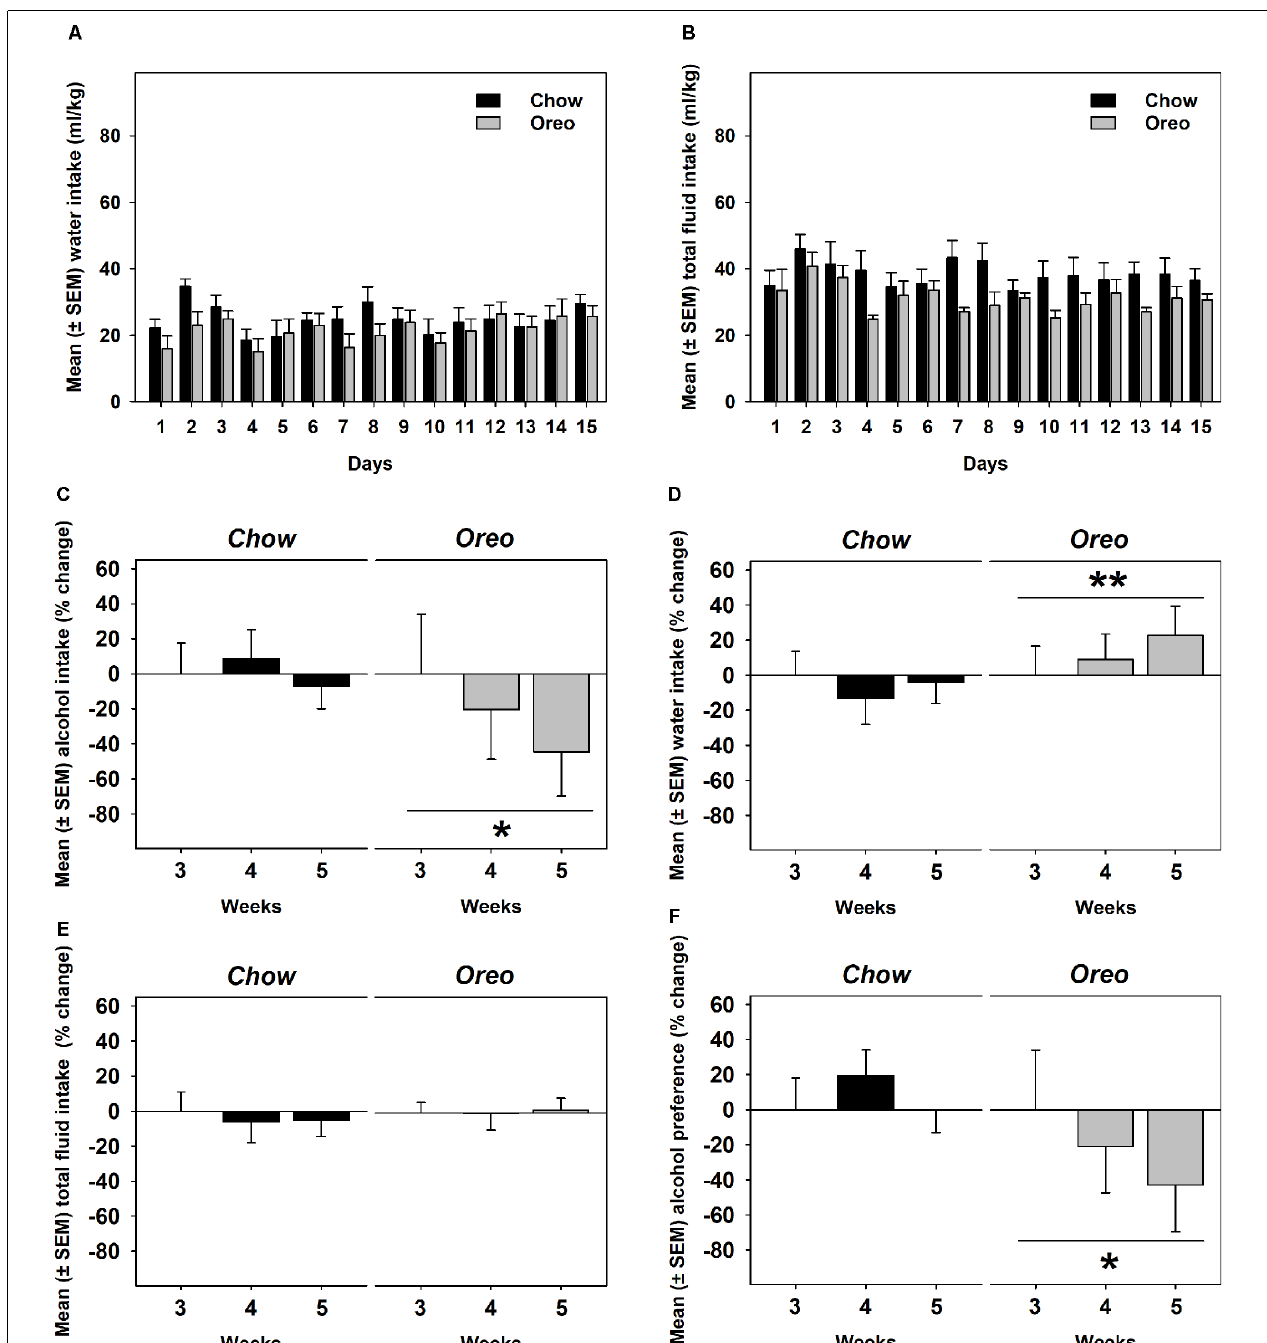
FIGURE 5 | Water, total fluid intake, and alcohol preference following suspension of patterned HPF cycling. Data compares the mean ( ± SEM) (A) water and (B) total fluid intake (ml/kg) between chow and HPF groups and no significant between group effects were observed. As noted earlier that significantly reduced alcohol drinking behavior only emerged towards last weeks of the alcohol testing period, we evaluated average (C) alcohol, (D) water, and (E) total fluid intakes during the last 3 weeks along with (F) alcohol preference. In the Oreo group, alcohol drinking and alcohol preference was reduced, water intake was increased but the total fluid intake did not change. On the other hand, no such changes were observed in the chow group of rats. ** p < 0.01, * p < 0.05 main effect of time.